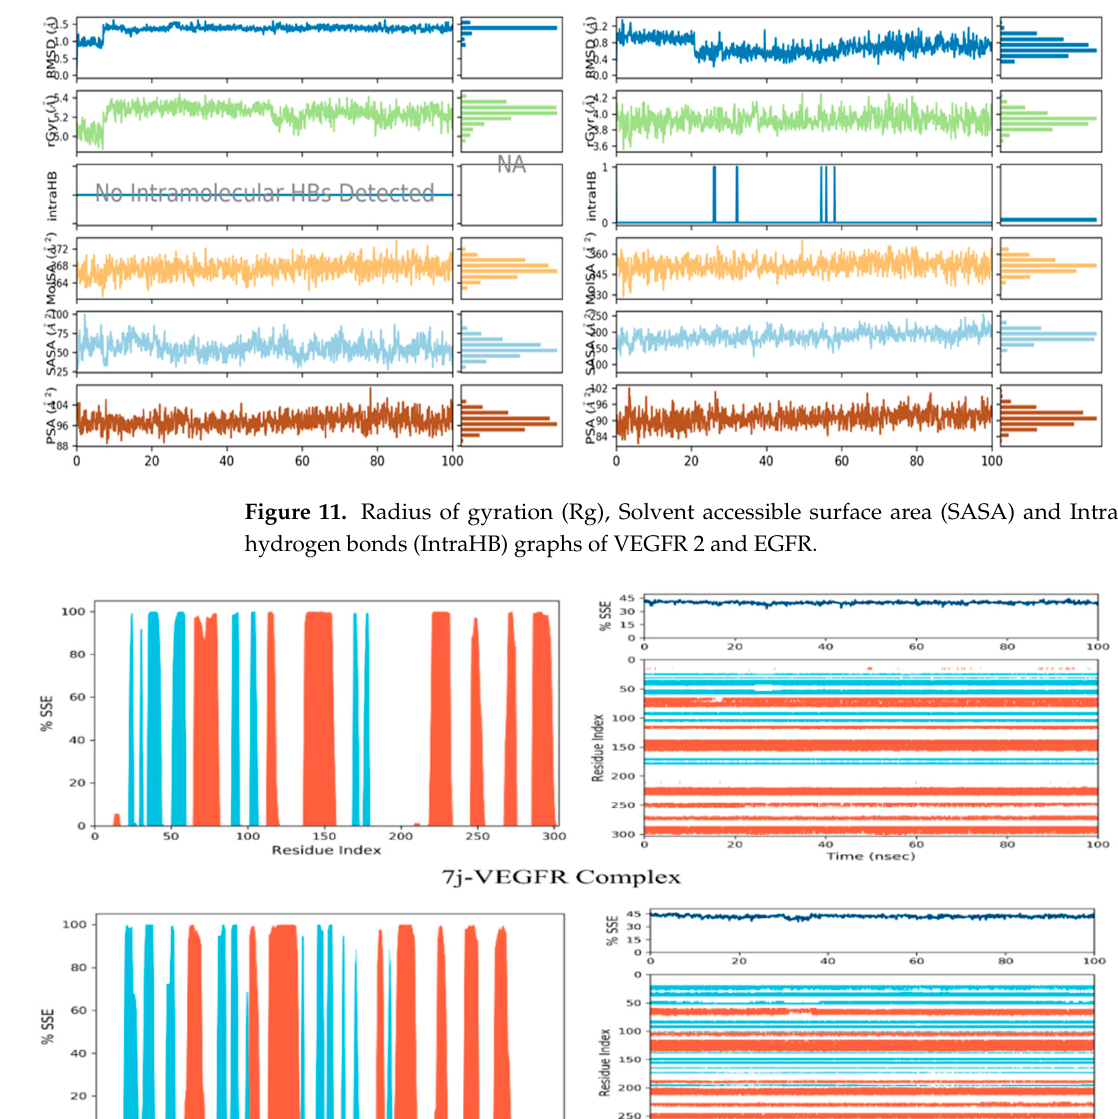
Figure 11. Radius of gyration (Rg), Solvent accessible surface area (SASA) and Intra-molecular hydrogen bonds (IntraHB) graphs of VEGFR 2 and EGFR.